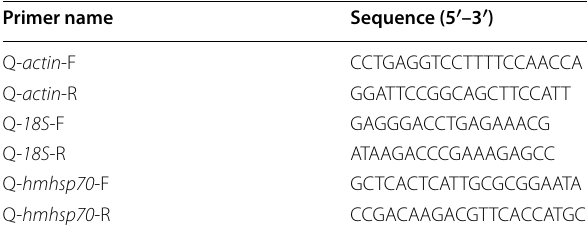
Table 1 Primers used for real-time qPCR analysis Primer